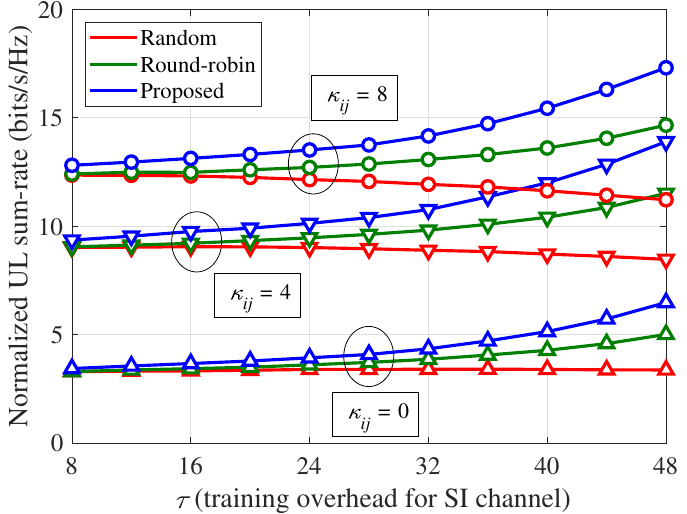
Figure 7. Normalized UL sum-rate ( η u ) per channel use according to the Rician factor ( κ ij ) and SI training overhead ( τ ): K u = 8, α = 70 dB, and 80 dB path loss between the BS and